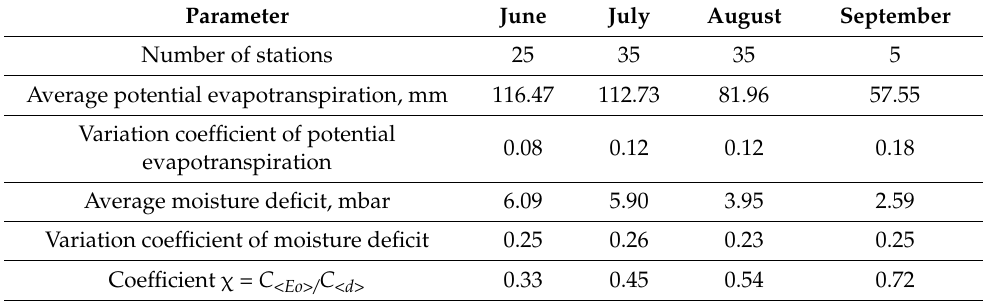
Table 1. Distribution of statistical parameters of potential evapotranspiration components for Siberian stations for